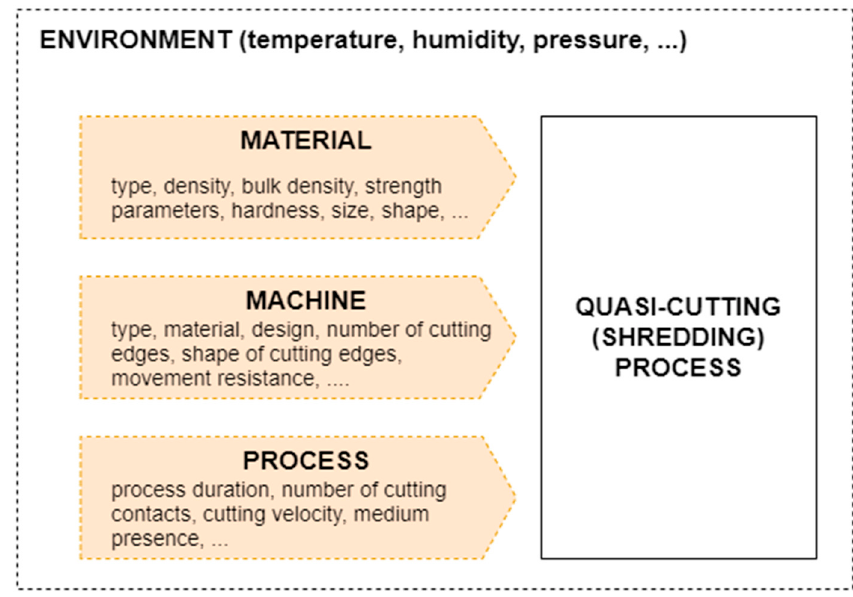
Figure 12. Factors influencing the quasi-cutting process. Own work on the basis of data from [115].